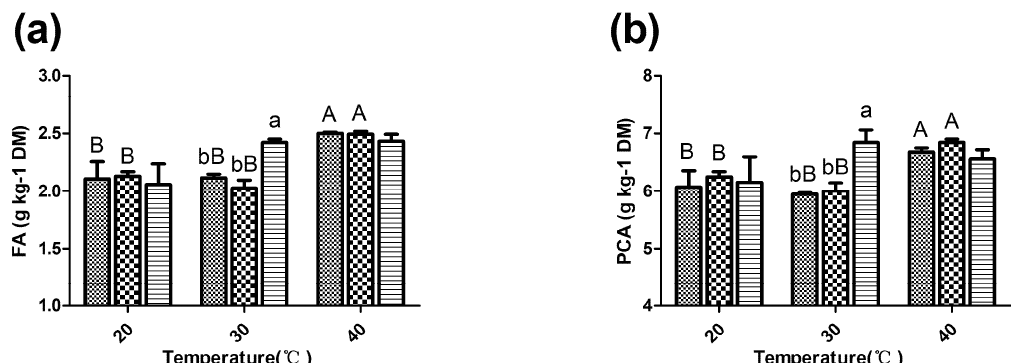
Figure 3. The phenolic acid extraction yields of sorghum silage. ( a ) Ferulic acid (FA) extraction yields. ( b ) p -coumaric acid (PCA) extraction yields. DM, dry matter; Control ; LF18, Lactobacillus farciminis inoculant ; LP23, Lactobacillus plantarum inoculant . Means within the same temperature (a, b) or within the same inoculant (A, B) with difference superscripts differ significantly from each other ( p < 0.05). Error bars indicate standard error of means.